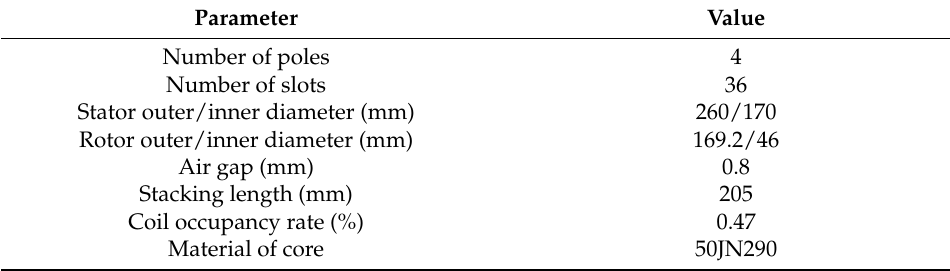
Table 2. Specifications of an objective